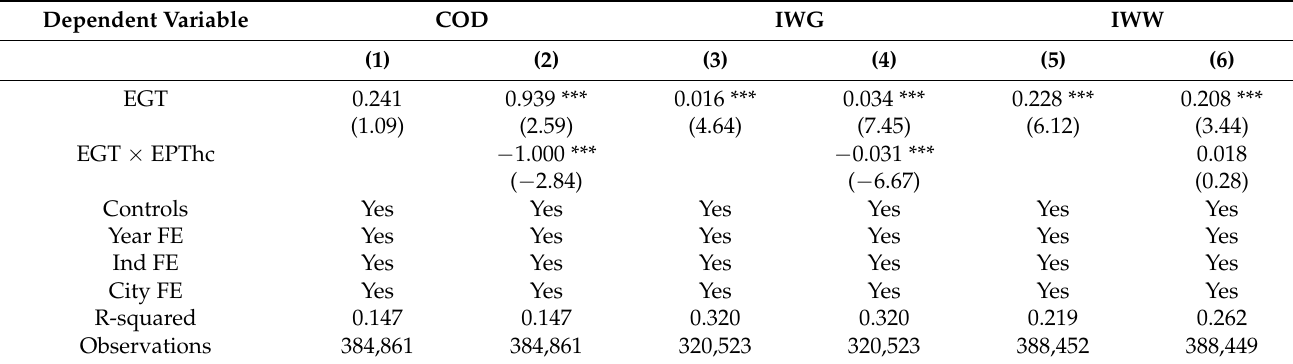
Table 5. Alternative measures of